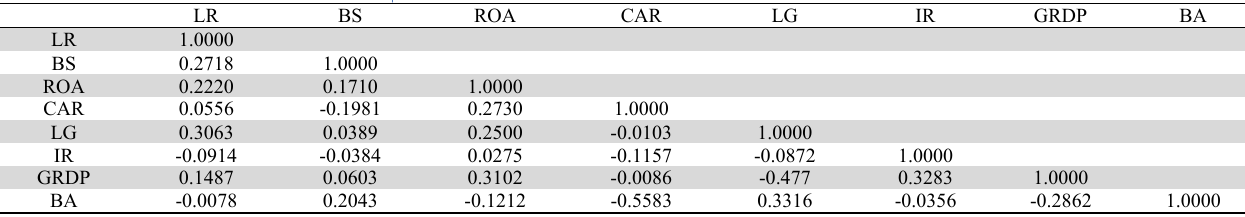
The correlation matrix of Islamic banks|